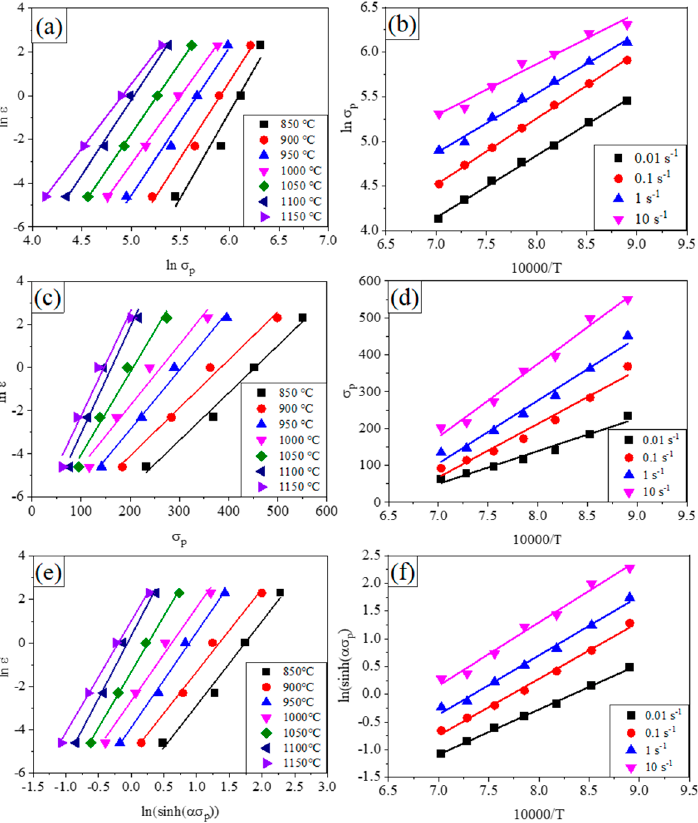
. Figure 6. Relationships between the deformation parameters ( a ) ln( 𝜀(cid:4662) ) and ln σ p ; ( b ) ln( σ p ) and Figure 6. Relationships between the deformation parameters ( a ) ln( ε ) and ln σ p ; ( b ) ln( σ p ) and . . 10000/T; ( c ) ln( 𝜀(cid:4662) ) and σ p ; ( d ) σ p and 10000/T; ( e ) ln( 𝜀(cid:4662) ) and ln(sinh( ασ p )) ; ( f ) ln(sinh( ασ p )) and 10000/T. ε ) and σ p ; ( d ) σ p and 10000/T; ( e ) ln( ε ) and ln(sinh( ασ p )) ; ( f ) ln(sinh( ασ p )) and 10,000/T; ( c ) ln(